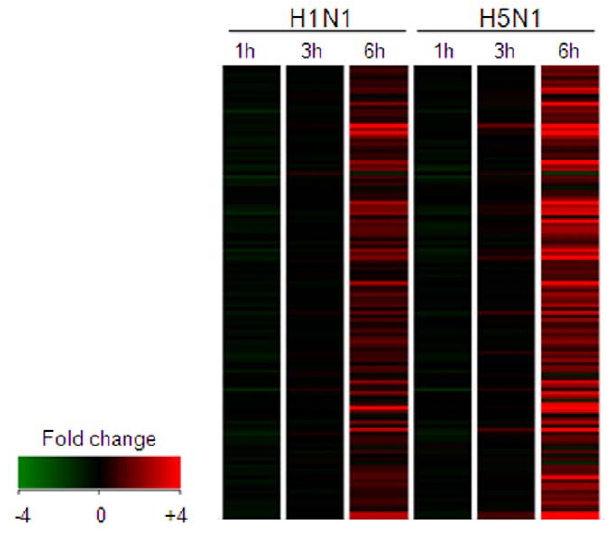
Figure 1. Heatmap showing microarray gene expression profiles of influenza A infected primary human macrophages at different post-infection time points. Expression of genes with p- values , 0.05 and fold change $ 6 1.5 in at least 1 of the 6 conditions in primary human macrophages infected with H5N1 or H1N1 viruses at 1, 3 and 6 h post-infection are shown. Note that the majority of gene expression changes were found at 6 h post-infection in both H5N1 and H1N1 infected cells. Data presented are averaged gene expression changes for three different individuals.